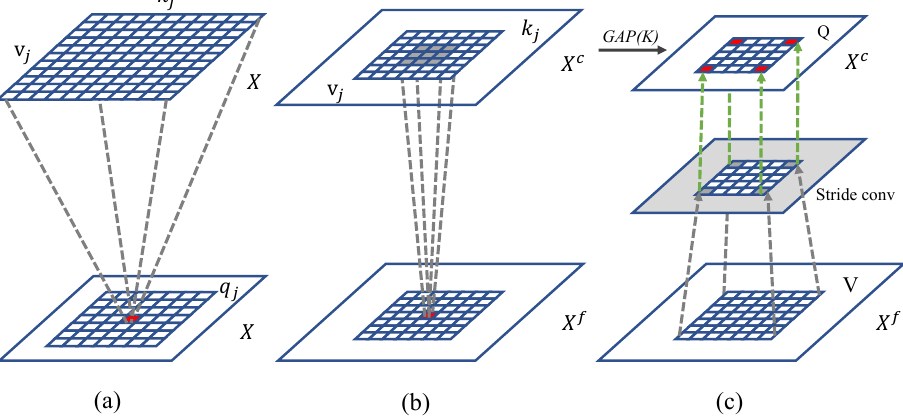
Figure 5. Architecture of the proposed feature pyramid transformer: ( a ) self-transformer, ( b ) ground- ing transformer, ( c ) rendering transformer. Firstly, the features from FPN are transformed and re-arranged. Then, the output features are concatenated with the original feature map to obtain the concatenated features. Finally, the Conv3 × 3 operation is carried out to reduce the channel and obtain the transformed feature